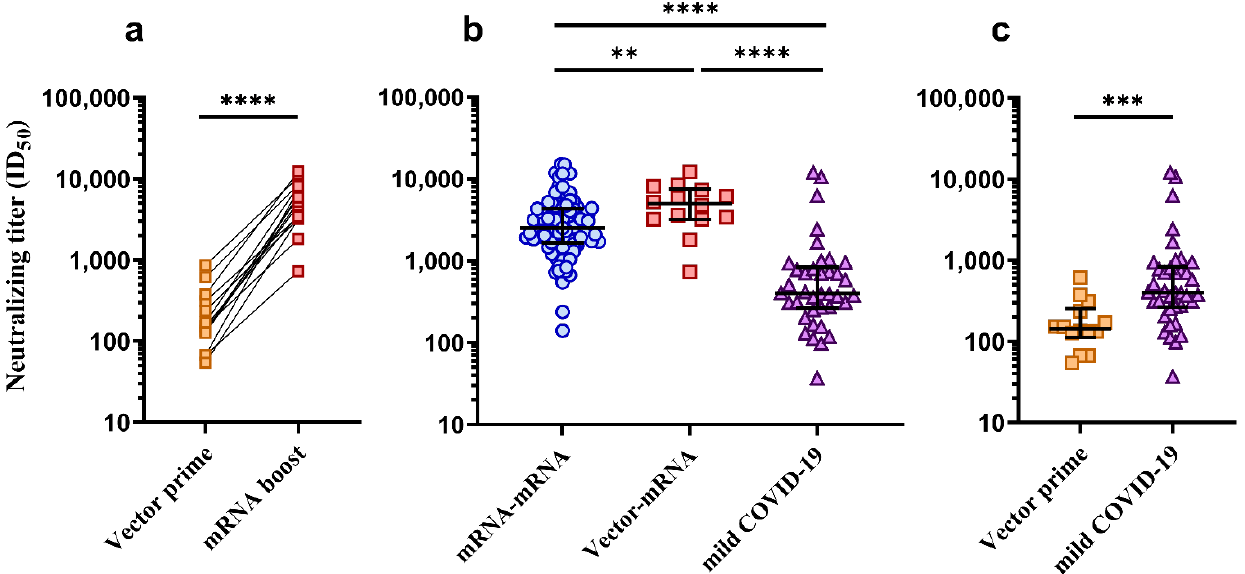
Figure 2. Comparison of neutralizing titers (ID 50 ) between mRNA–mRNA and vector–mRNA prime-boost COVID-19 vaccine regimens and SARS-CoV-2 infected individuals presenting with mild COVID-19. ( a ) Comparison of neutralizing titers in the vector–mRNA group ( n = 15) between the one-month post prime dose (Vector prime, yellow squares) vs. one-month post booster (mRNA boost, red squares). Neutralizing titers at the one-month post boost time point were found to be significantly higher than the one-month post prime time point (**** p < 0.0001, Wilcoxon ranked t test). ( b ) Comparison of neutralizing titers between the mRNA–mRNA (blue circles, n = 96), vector–mRNA (red squares, n = 15) and mild COVID-19 (purple triangles, n = 38) groups at one month post boost or one month post symptom onset. The vector–mRNA group was found to have significantly higher neutralizing titers when compared to the mRNA–mRNA group (** p = 0.0071, Mann–Whitney U test). Both the vector–mRNA group and the mRNA–mRNA group were found to have significantly higher neutralizing titers when compared to the mild COVID-19 group (**** p < 0.0001, Mann–Whitney U tests). ( c ) Comparison of neutralizing titers between the vector–mRNA group ( n = 15) at one month post prime dose (Vector prime, yellow squares) and the mild COVID-19 group (purple triangles). Those in the mild COVID-19 group were found to have significantly higher neutralizing titers (*** p = 0.0003, Mann–Whitney U test). The bold lines represent the median and interquartile